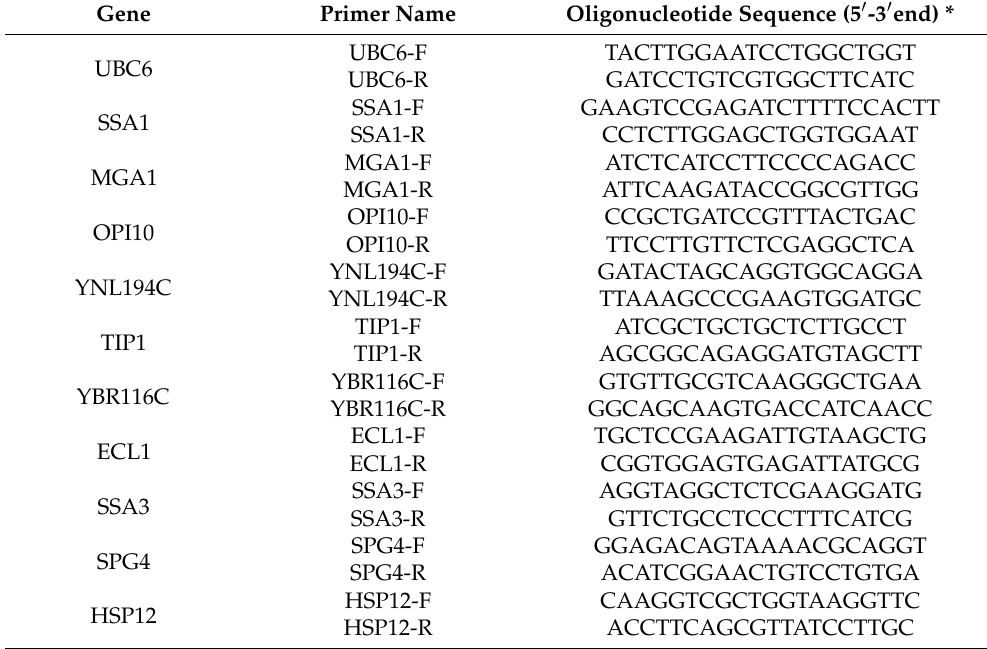
Table 1. Primer sequences for qRT-PCR gene